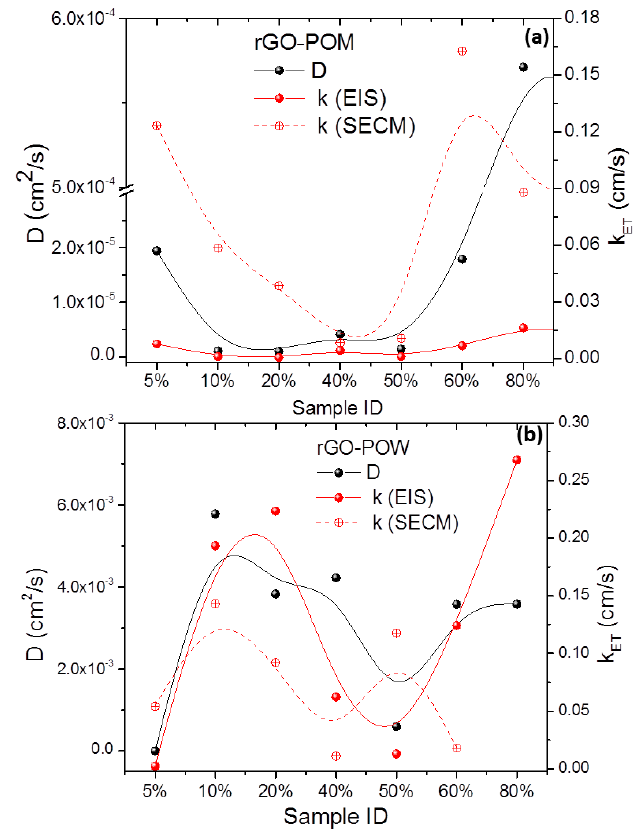
Figure 6. Variation of diffusion coefficient (D) and heterogeneous electron transfer rate constant ( k ET ) derived from EIS data modeling and SECM for: ( a ) rGO–POM x ; and ( b ) rGO–POW x graphene-based hybrid series.